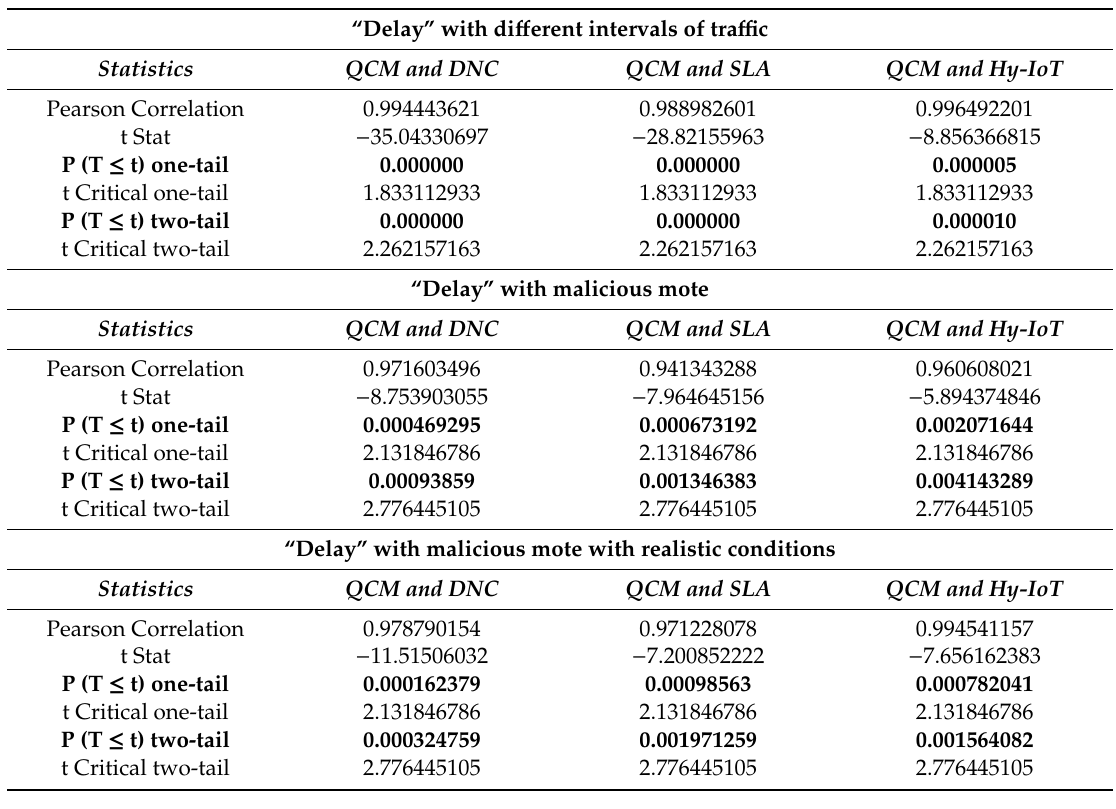
Figure 4. Delay with different intervals of traffic. Table 4. Inferential analysis of the proposed QCM algorithm in terms of “delay”